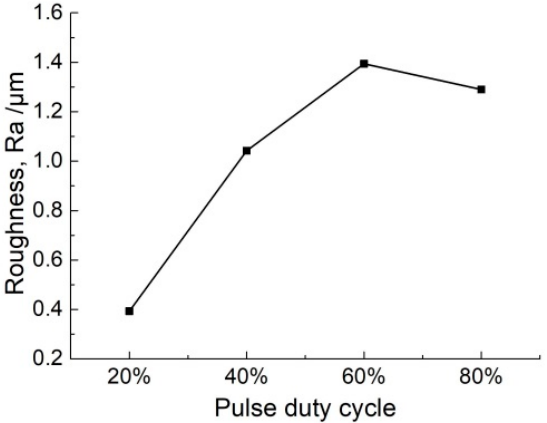
Figure 13. The profile of micro-grooves generated with different pulse duty cycles ( P in = 0.8 MPa, U = 35 V, f = 1 kHz, t on = 20 s).